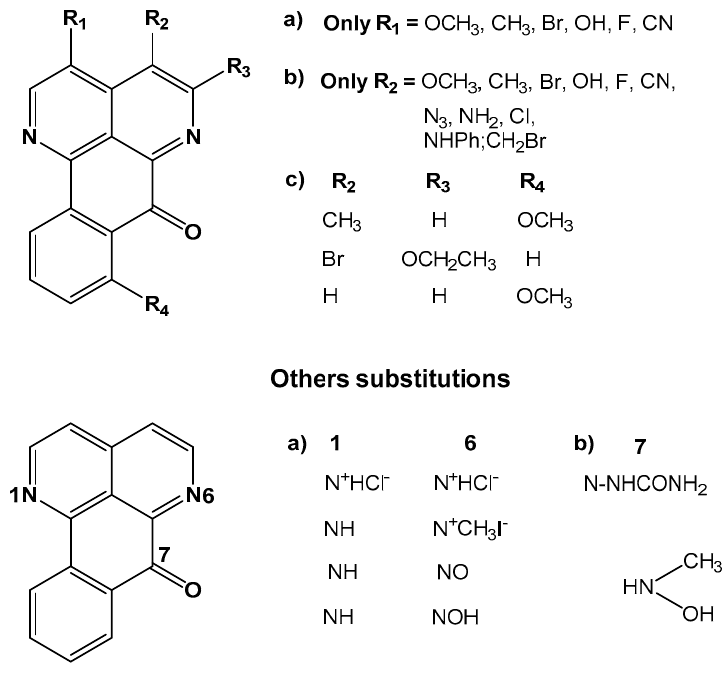
Figure 10. Chemical structure of sampangine derivatives [154].